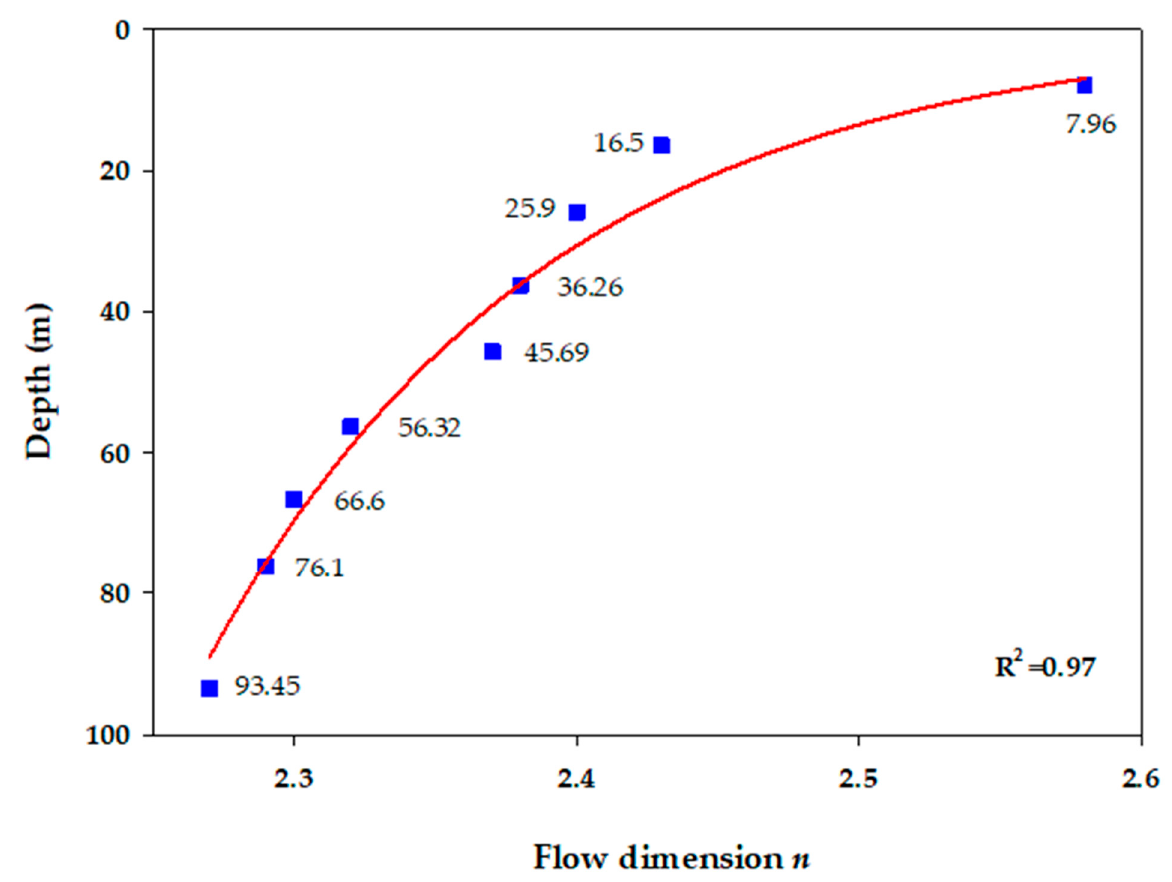
Figure 10. Relationship between n and depth factor.